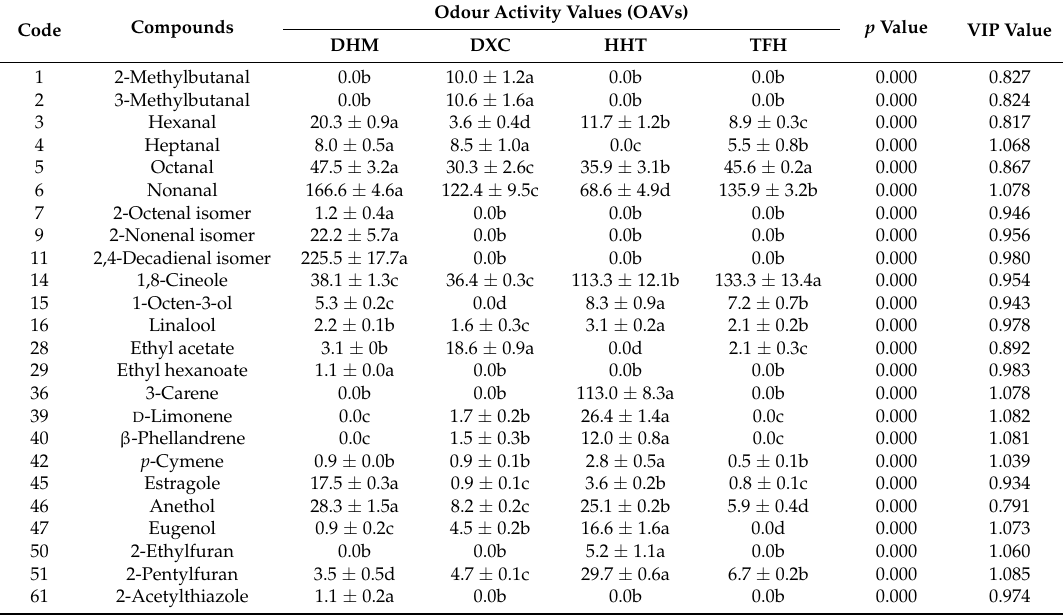
Table 2. OAVs of odour-active compounds in marinated pork